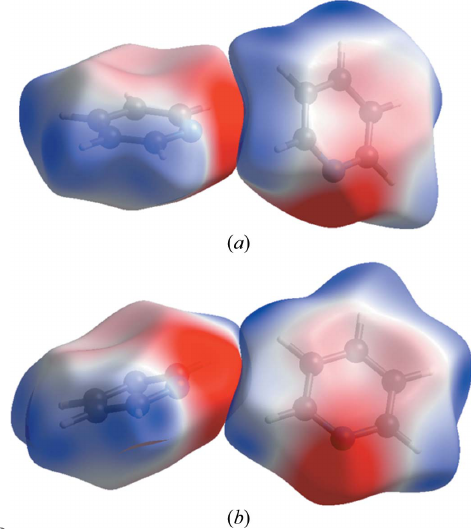
Figure 3 CH (cid:2)(cid:2)(cid:2) N contacts in ( a ) phase II and ( b ) phase III, depicted using Hirshfeld surfaces coloured according to electrostatic potential. Note the better alignment of the blue (positive) and red (negative) regions of the potentials in phase II. The potentials are mapped over the range (cid:8) 0.05 a.u.